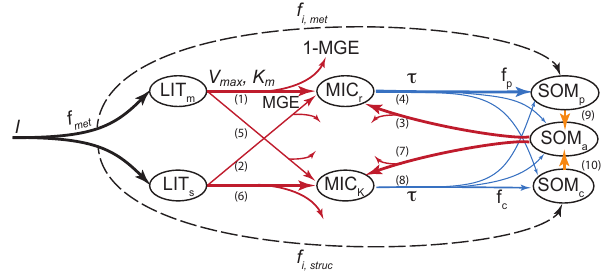
Figure 1. Soil C pools and fluxes represented in MIMICS. Litter inputs ( I ) are partitioned into metabolic and structural litter pools (LIT m and LIT s ) based on litter quality ( f met ) . Decomposition of litter and available SOM pools (SOM a ) are governed by tempera- ture sensitive Michaelis–Menten kinetics ( V max and K m ) , red lines. Microbial growth efficiency (MGE) determines the partitioning of C fluxes entering microbial biomass pools vs. heterotrophic respira- tion. Turnover of the microbial biomass ( τ , blue) depends on micro- bial functional type (MIC r and MIC K ) , and is partitioned into avail- able, physically protected, and chemically recalcitrant SOM pools (SOM a , SOM p , and SOM c , respectively). Bracket numbers corre- spond to the equations for fluxes described in Appendix A1. The definition and values of parameters are included in Table